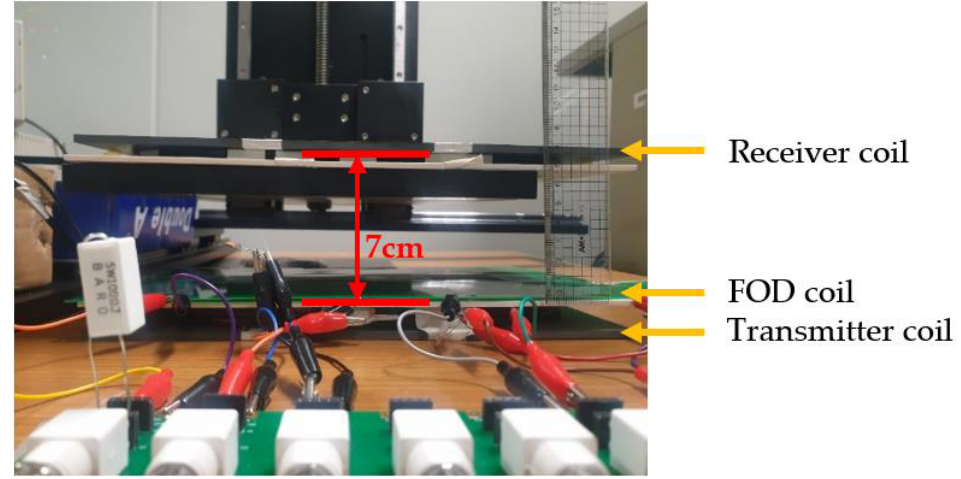
Figure 15. Experimental environment to test the effect between the wireless power transfer operation and the metal object detection (MOD) operation.